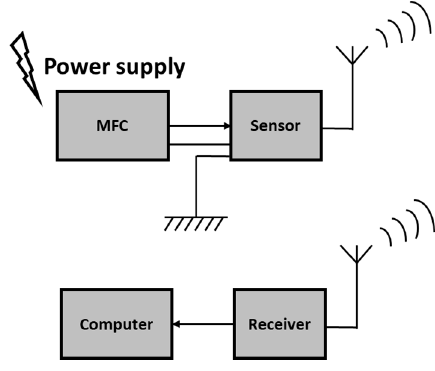
Figure 3. Schematic diagram of a remote sensor powered by MFC.